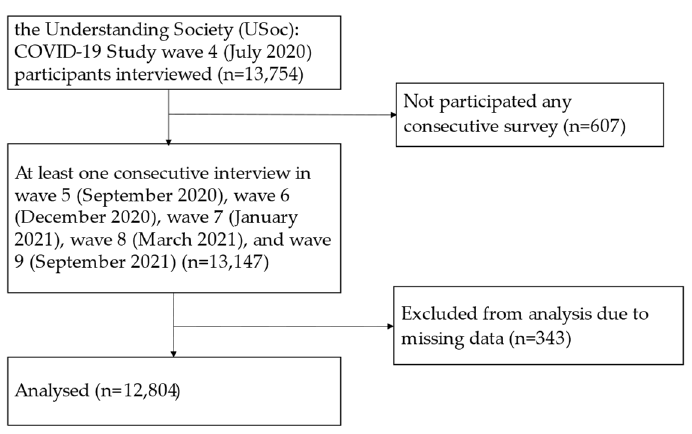
Figure A1. The enrolment of respondents and the selection procedure. Table A1. Crosstabulation between sleep problems, demo social characteristics, baseline chronic conditions and incidents of chronic disease.